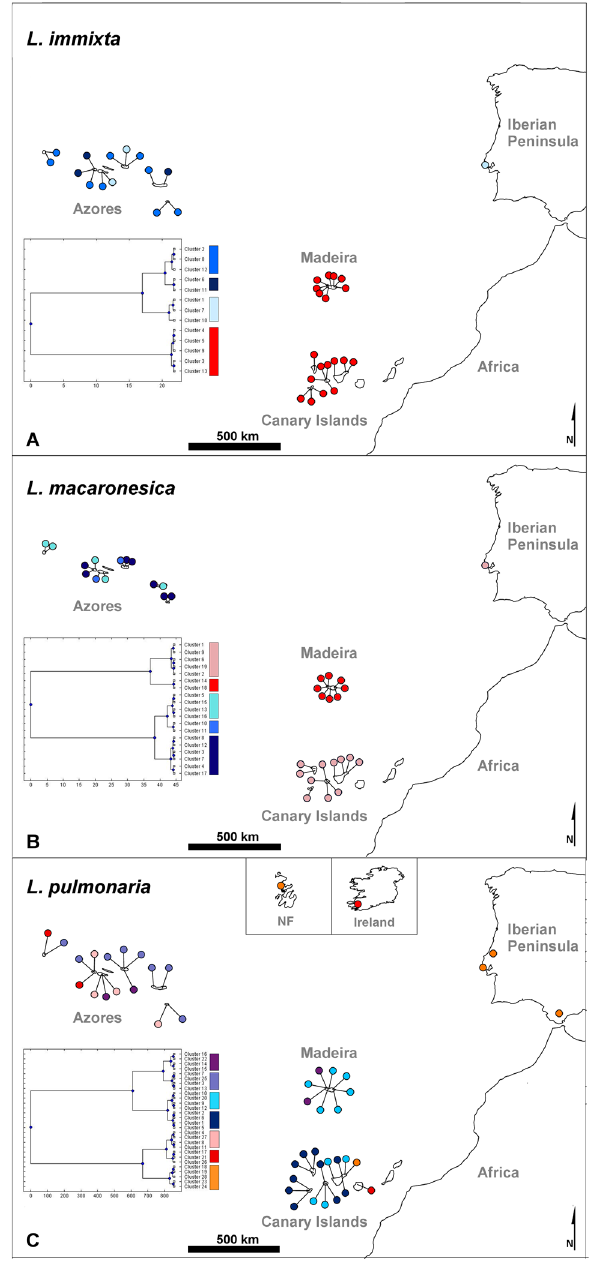
Figure 3. Population structure analysis for Lobaria sampled from the Macaronesian islands, the Iberian Peninsula and adjacent areas. Shown are genetic clusters from mixture analysis performed in BAPS v. 5.4, http:// www. helsi nki. fi/ bsg/ softw are/ BAPS/; inset: neighbor-joining trees of Nei’s genetic distance among clusters, averaged over loci. ( A ) Lobaria immixta . ( B ) L. macaronesica . ( C ) L. pulmonaria . NF,